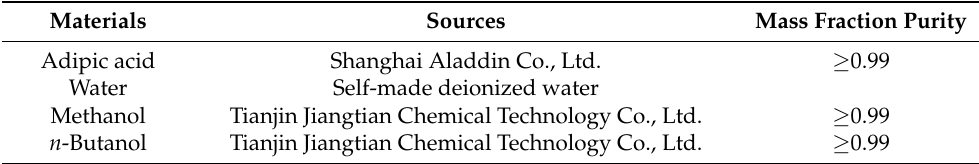
Table 1. Sources and mass fraction purity of